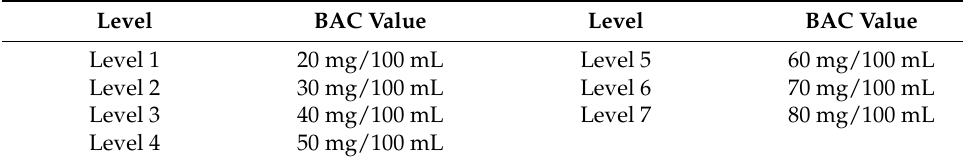
Table 2. Level of